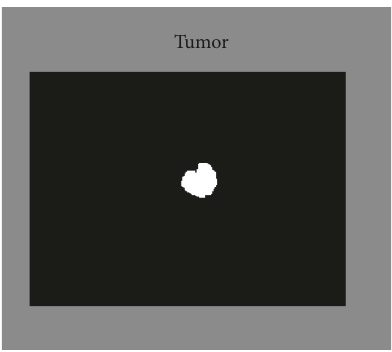
Figure 17: Brain tumor detection